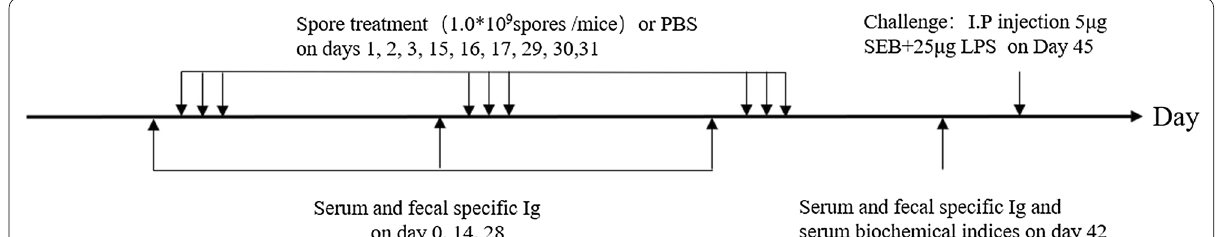
Fig. 1 Immunization and challenge protocol for experiment mice. Mice were treated with 10 9 spores on days 1, 2, 3, 15, 16, 17, 29, 30, and 31 and blood and stool samples were collected for specific Ig measurement on days 0, 14, 28 and 42 respectively. On day 45, mice were challenged with